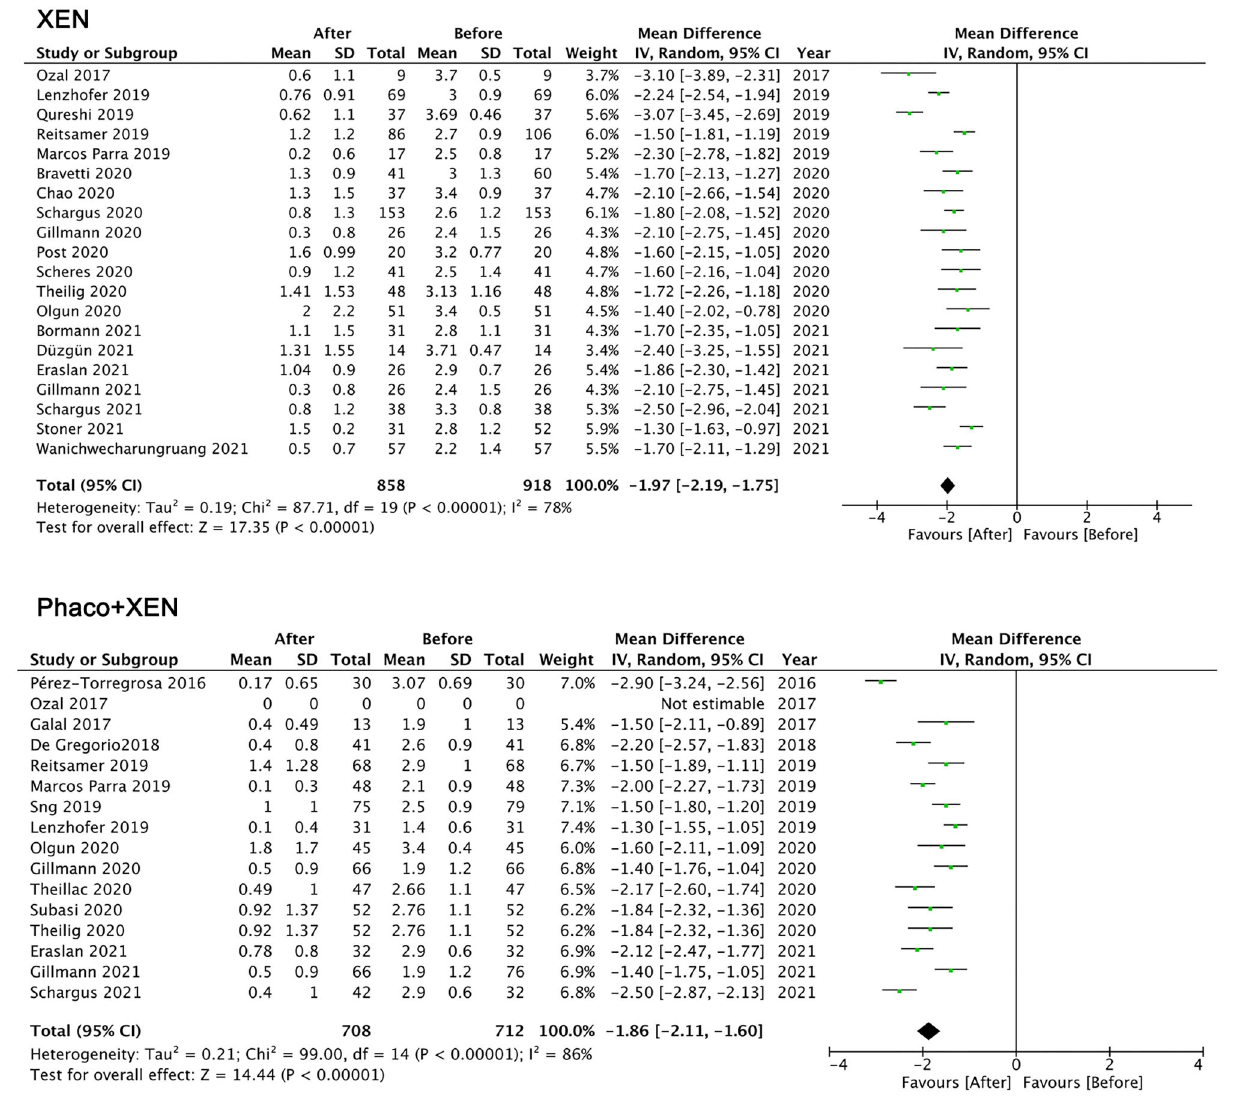
and cataracts (26, 51). None of the patients suffered from loss of light perception in any of the published